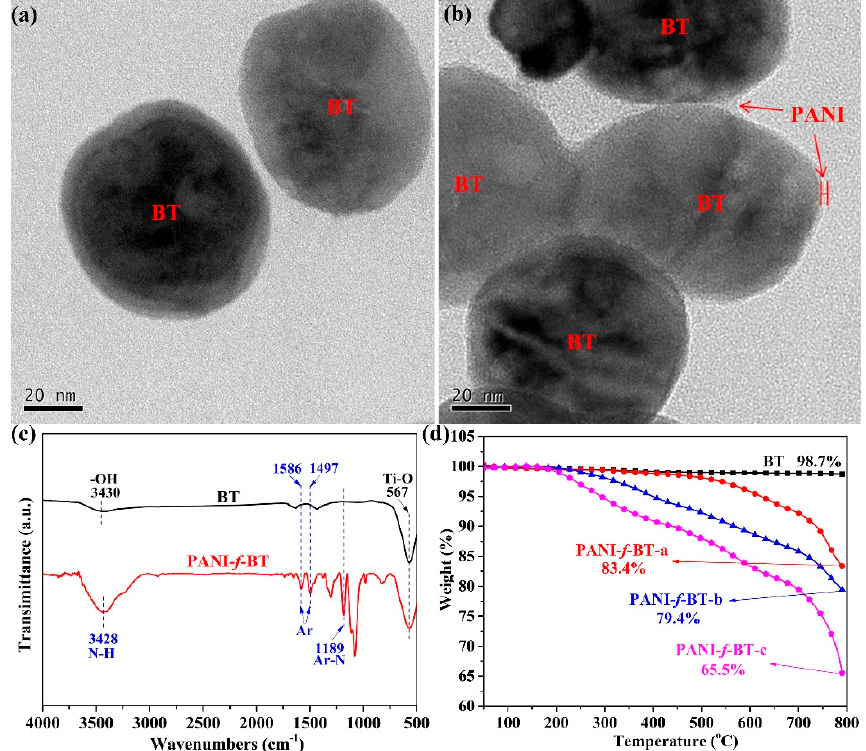
Figure 2. Transmission electron microscopy (TEM) images of ( a ) barium titanate (BT) and ( b ) polyaniline functionalized barium titanate (PANI- f -BT-b); ( c ) Fourier transform infrared spectroscopy (FTIR) spectrum of BT and PANI- f -BT-b; ( d ) Thermogravimetric analysis (TGA) curves of the nanofillers.